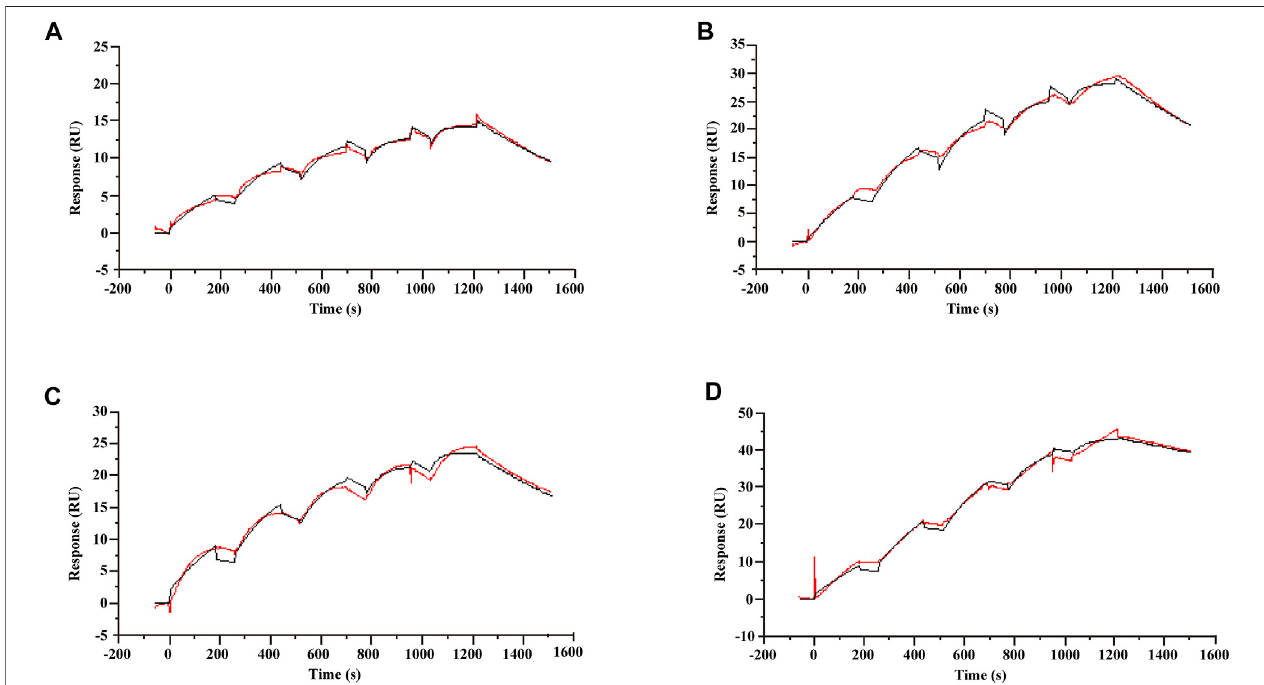
FIGURE 1 | Kinetic pro fi le for Ro5-4864, PK11195, protoporphyrin IX and koumine binding to TSPO proteoliposomes determined using single-cycle kinetics. (A – D) The sensorgram of Ro5-4864 (A) , PK11195 (B) , protoporphyrin IX (C) and koumine (D) binding to the TSPO proteoliposomes. The Ro5-4864, PK11195 and koumine concentrations were 3.125, 6.25, 12.5, 25 and 50 nM, and the protoporphyrin IX concentrations were 25, 50, 100, 200 and 400 nM. The running buffer contained 10 mM phosphate buffer, 2.7 mM KCl, 137 mM NaCl and 1% DMSO. Binding data were collected at a fl ow rate of 30 μ l/min. The association and dissociation phases were 180 and 300 s, respectively. The red traces represent the experimental data, and the black traces represent the global fi t of the data to a Langmuir 1:1 interaction model. Sensorgrams show blank and reference subtracted data, and a DMSO correction was also applied. A representative result from three independent experiments is